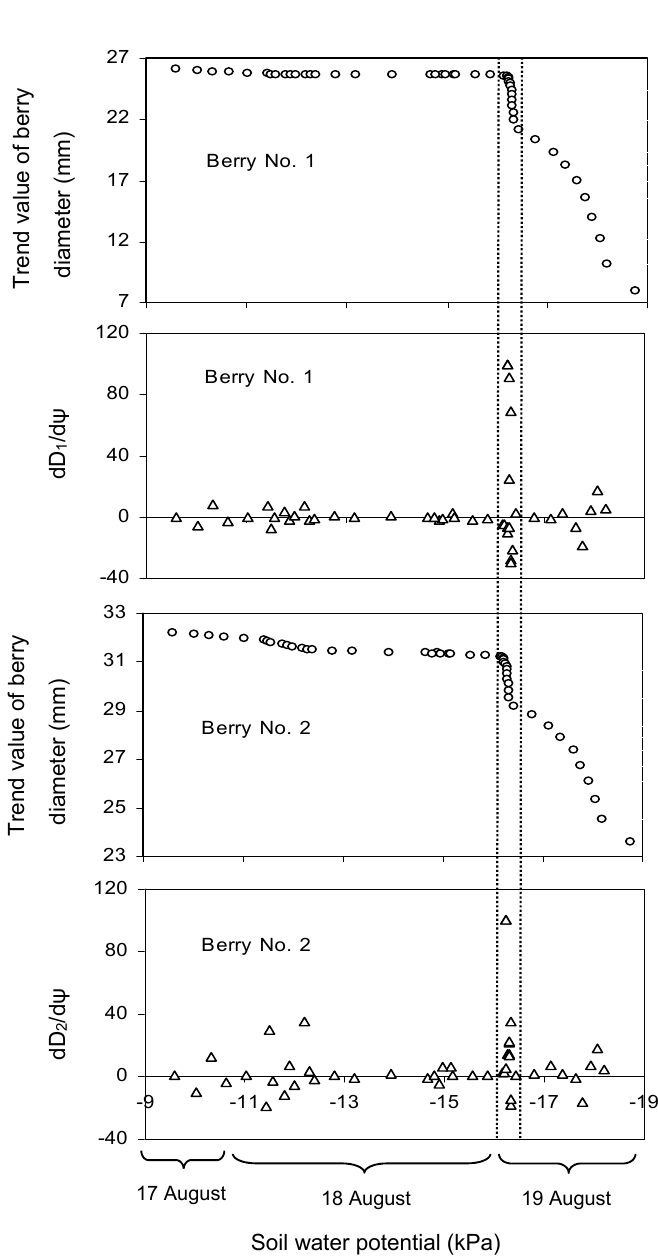
Figure 3. Effect of average soil water potential ( ψ ) (0.1 m soil depth, n = 6) on the trend value of berry diameter in berry development Stage III (dD 1 /d ψ and dD 2 /d ψ represent the differential of trend values of berry diameter No. 1 and No. 2 on soil water potential). The x-axes scale of ψ is from − 7.14 kPa (9:00, 17 August) to − 20.39 kPa (20:00, 19 August).